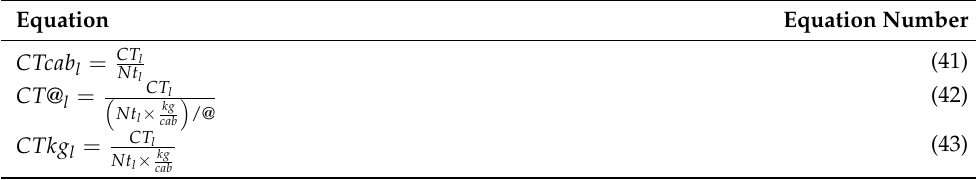
Table 8. Equations that make up the total cost that compose the cost calculation model for swine production.